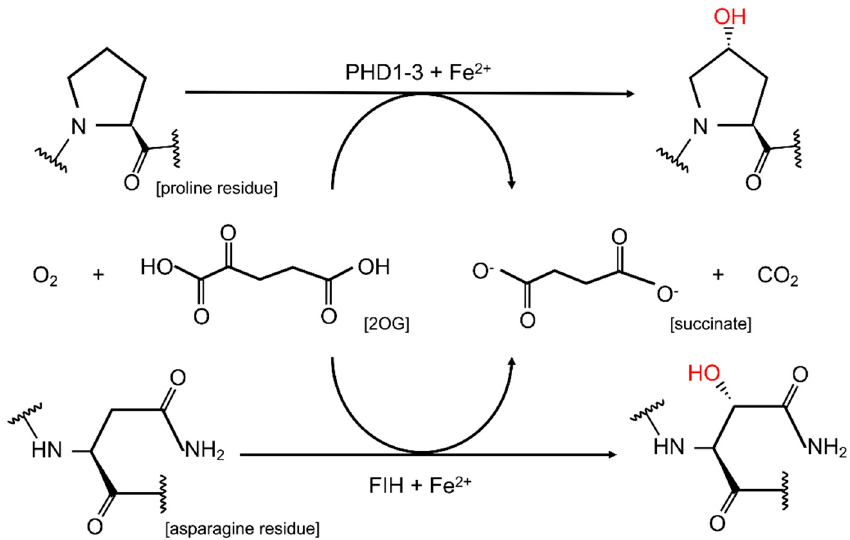
Figure 2. Enzymatic reaction of HIF- α subunits: HIF prolyl hydroxylases (PHD1-3) catalyze the hydroxylation of proline residues ( upper panel ) and factor inhibiting HIF (FIH) catalyzes the hydroxylation of asparagine residues ( lower panel ); both using oxygen (O 2 ), iron (Fe 2 + ), α -ketoglutarate (also known as 2-oxaloglutarate; 2-OG) and ascorbic acid (vitamin C; not shown) as co- substrates.